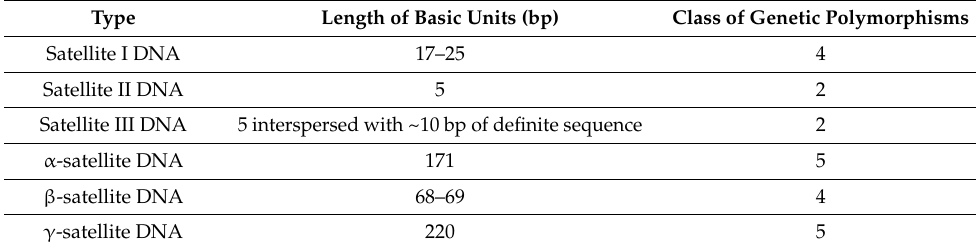
Table 2. Satellite DNAs in